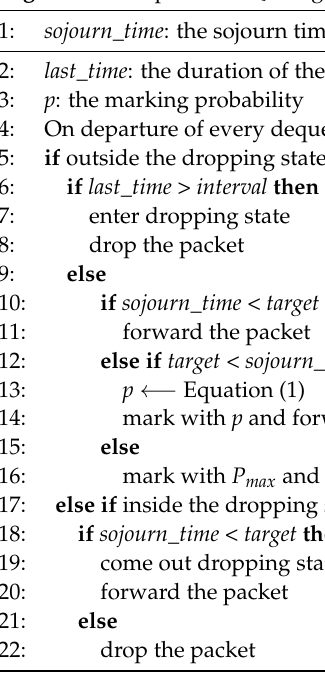
Algorithm 1 Improved AQM